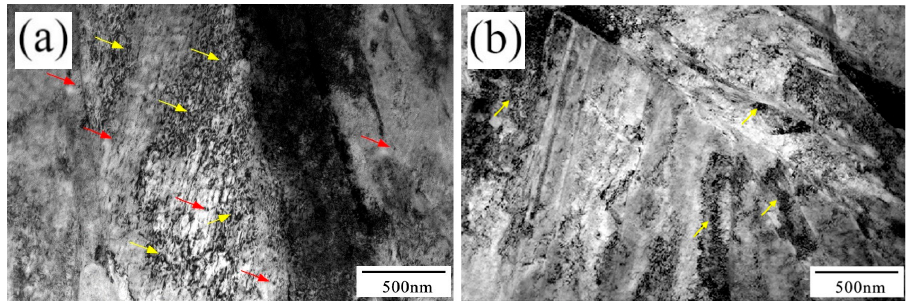
Figure 16. TEM images of two investigated steels. The red arrows represent the Nb(C, N), yellow arrows represent the dislocation. ( a ) 22Mn3SiNb, ( b ) 22MnB5.